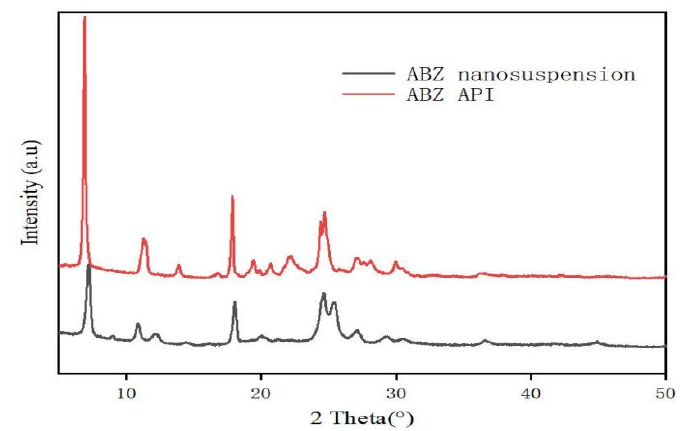
Figure 8. XRD pattern (B) of bulk drug and albendazole nanocrystals.